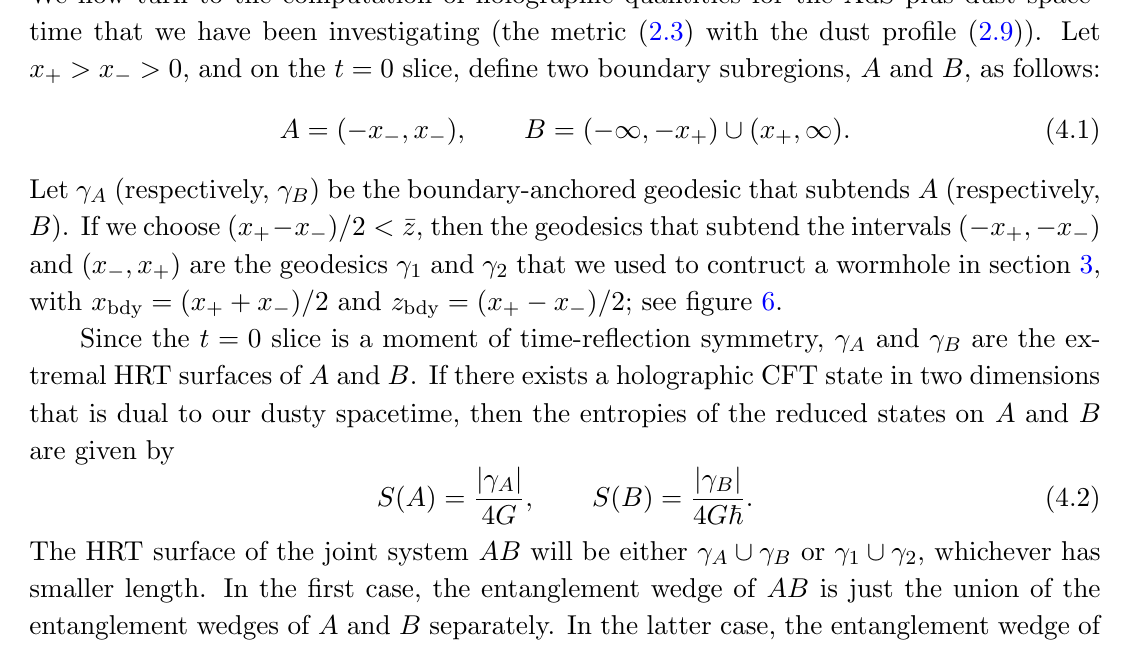
Figure 6 . Summary of the labels de(cid:12)ned in sections 3 and 4. When entanglement wedge for AB is in the connected phase, and the entanglement wedge cross section (cid:0) connects (cid:13) 1 with (cid:13) 2